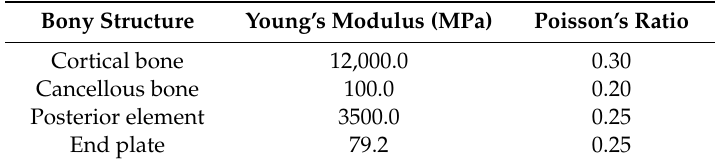
Table 3. Material properties of the lumbar vertebrae in the finite element analysis (FEA) model.